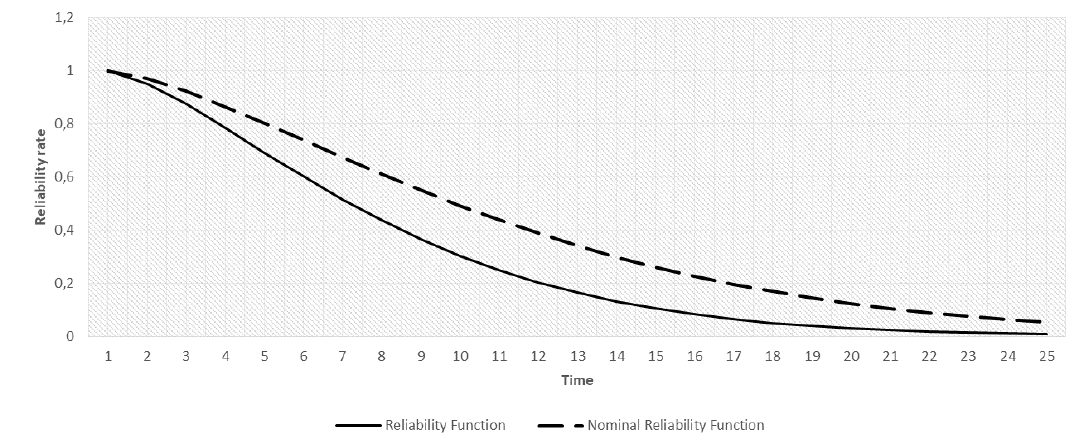
Figure 3. Reliability function for one